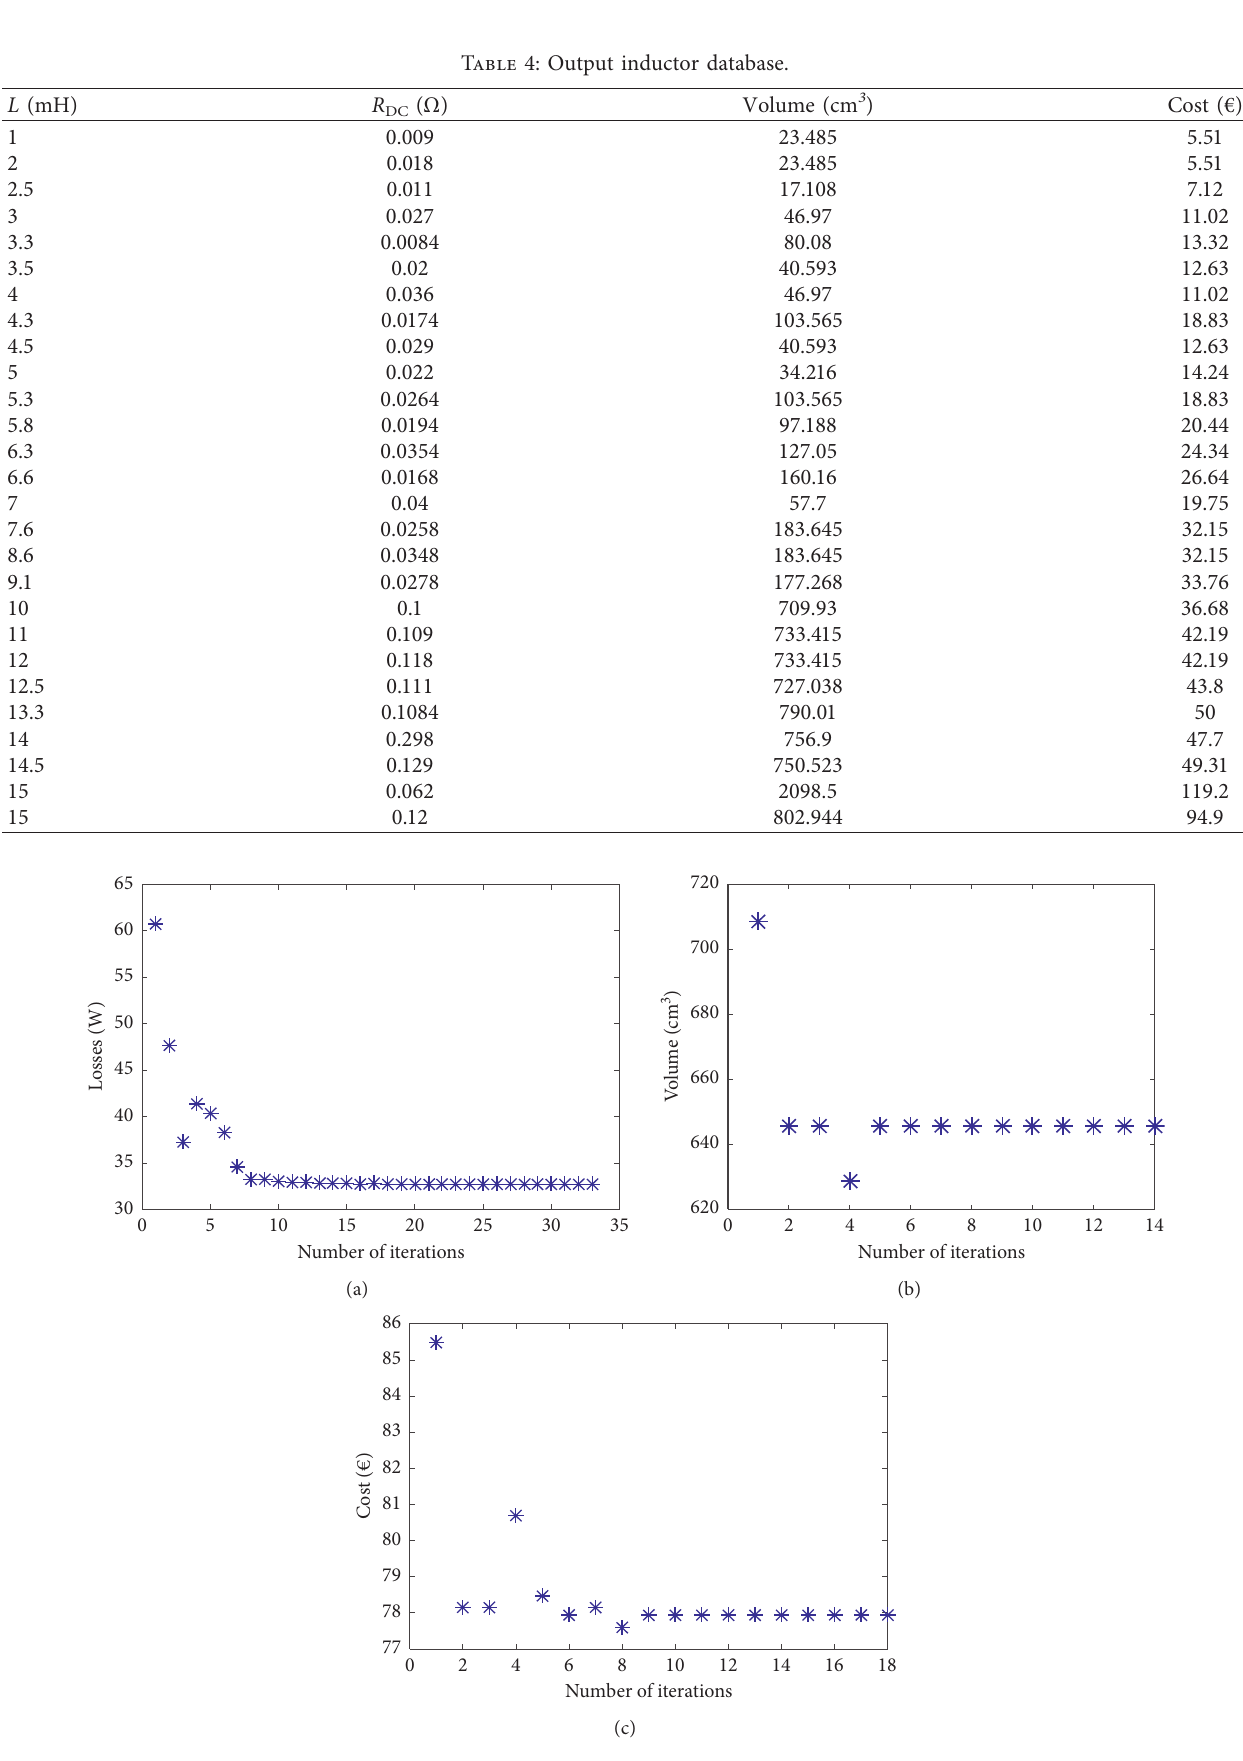
Figure 7: Convergence of the fitness functions according to the number of